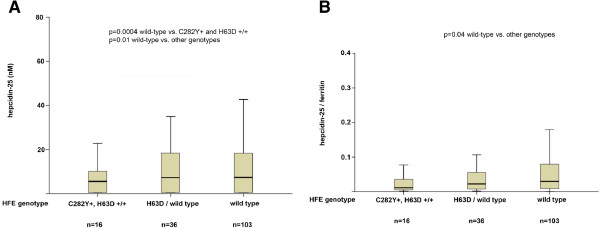
Effect of HFE C282Y and H63D genotype status (wild-type, heterozygosity for the H63D mutation, other genotypes) on hepcidin-25 levels (panel A), and hepcidin-25 / ferritin ratio (panel B) in 155 CHD patients from Northern Italy.